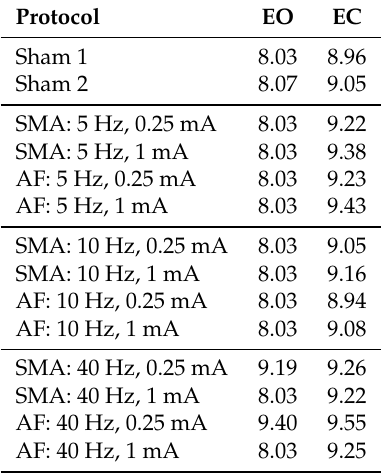
Table 2. Individual Alpha Frequency during Eyes Open (EO) stage and Eyes Closed (EC) stage for all protocols and artifact removal